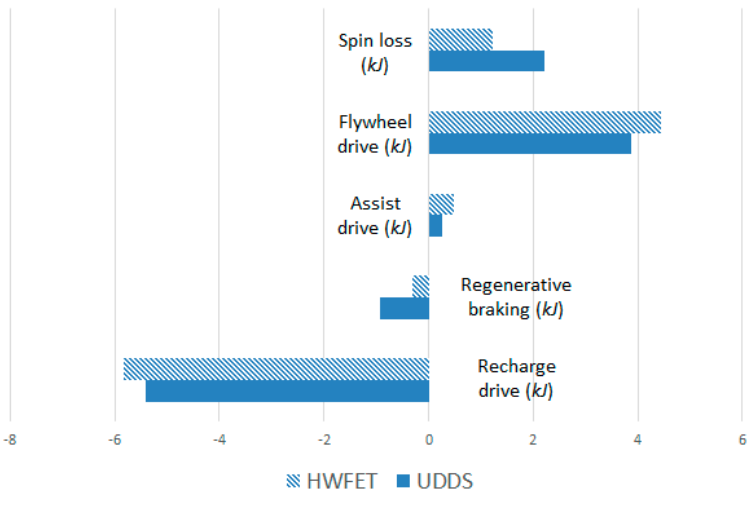
Figure 24. FESS energy input and output analysis in drive cycle simulations.